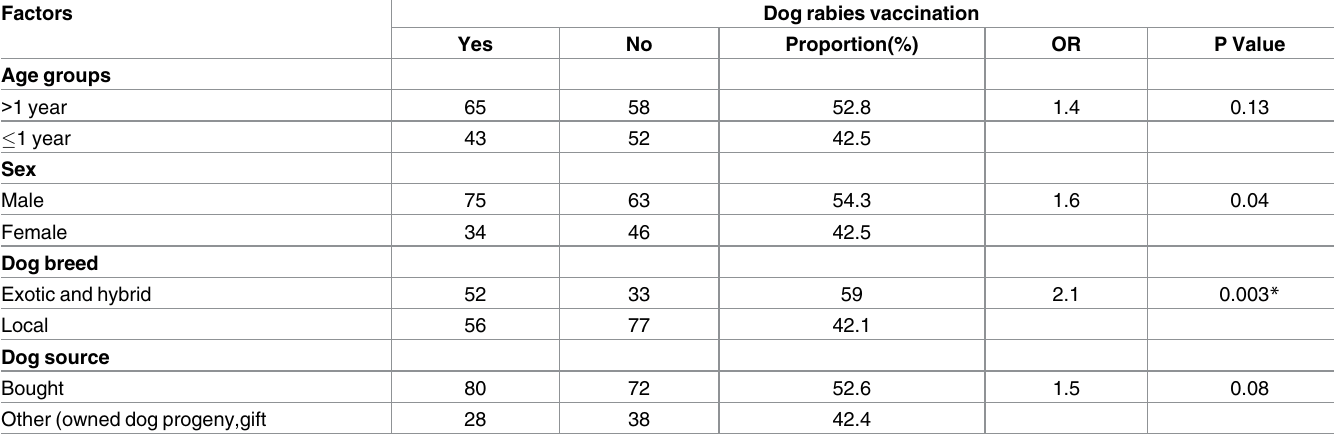
Table 3. Dog characteristics associated to rabies